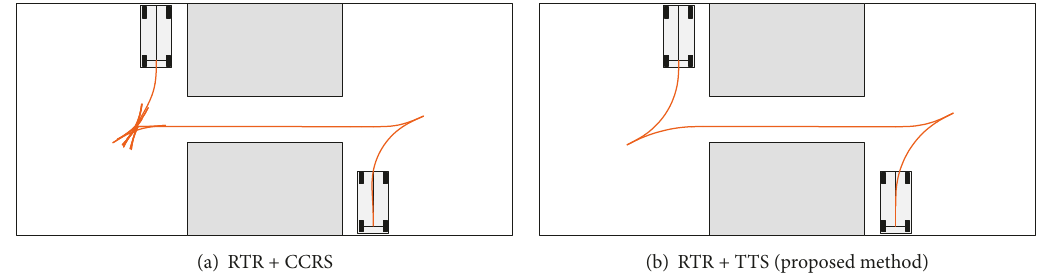
Figure 14: Crossing a narrow